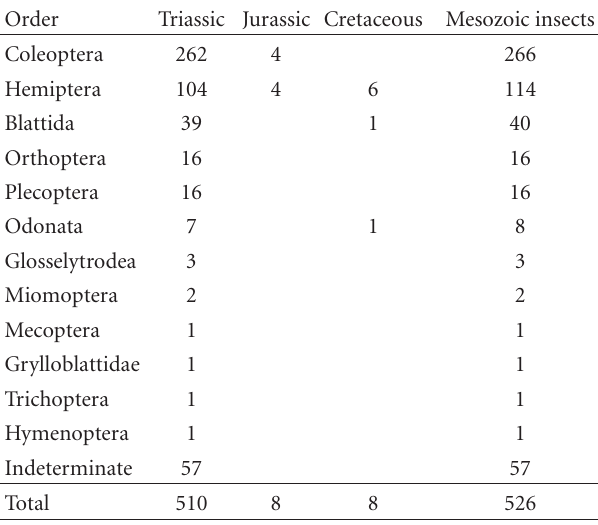
Table 1: Mesozoic insects from